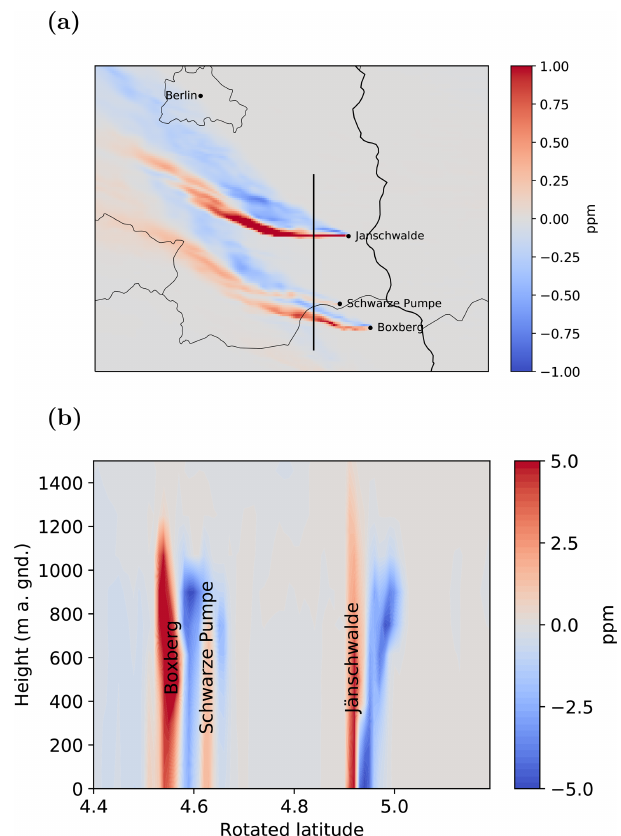
Figure 12. Difference on 2 July 2015 11:00LT between power plant CO 2 tracer with explicit plume rise (CO2_PP-PR) and released according to standard EMEP SNAP 1 profile (CO2_PP-EMEP). (a) Map of the difference in column-averaged dry air mole XCO 2 fractions. (b) Vertical cross-section of the difference in CO 2 along the transect indicated in panel (a) . The length of this cross-section is about